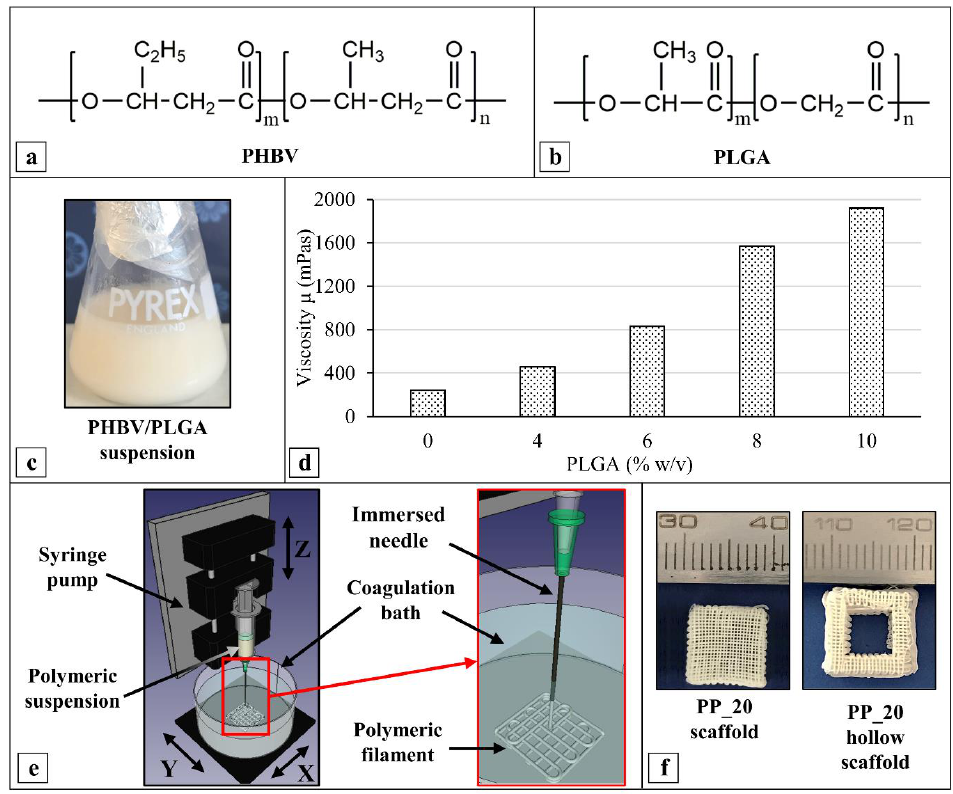
Figure 2. Chemical structure of the two aliphatic polyesters employed in this study, i.e., ( a ) poly(3- hydroxybutyrate- co -3-hydroxyvalerate) (PHBV) and ( b ) poly(D,L-lactide- co -glycolide) (PLGA); ( c ) representative picture of a PHBV suspension in a PLGA chloroform solution (PHBV/PLGA 80:20 suspension) employed for scaffold fabrication by CAWS; ( d ) viscosity of PHBV/PLGA suspensions as a function of PLGA concentration (only a single measurement was carried for each kind of sample due to the large volume of suspension, i.e., 50 mL, and relevant polymer mass, i.e., 20 g, required for analysis); ( e ) schematics of the CAWS process highlighting details about polymeric mixture extrusion directly into a coagulation bath and the layer-by-layer deposition of the solidifying fiber; ( f ) representative pictures of PP_20 scaffolds with standard shape ( left ) as well as hollow geometry designed and fabricated as a proof of concept of CAWS process versatility ( right